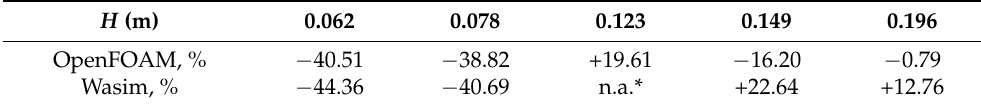
Table 11. Difference of numerical and experimental total resistance coefficients for the KRISO